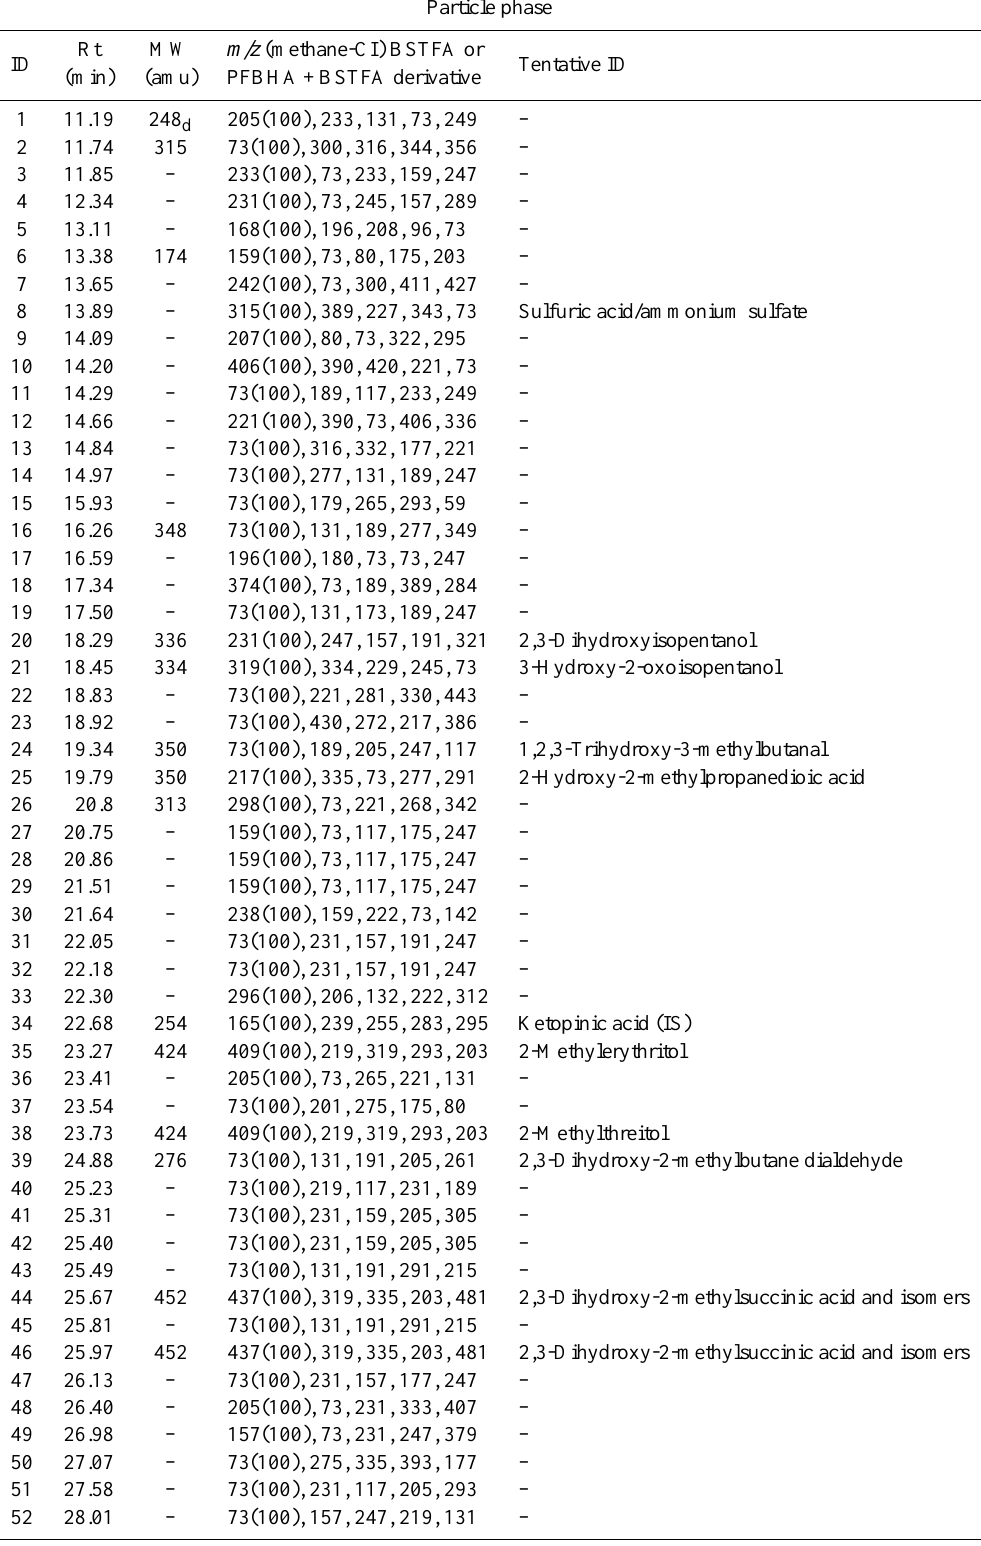
Table 2a. SOA and gas-phase compounds identified in the present study. For the particle phase the MW of the BSTFA derivative is given, and for the gas phase the MW of the underivatized compound is given. Methyltetrols were also detected in isoprene SOA. Particle